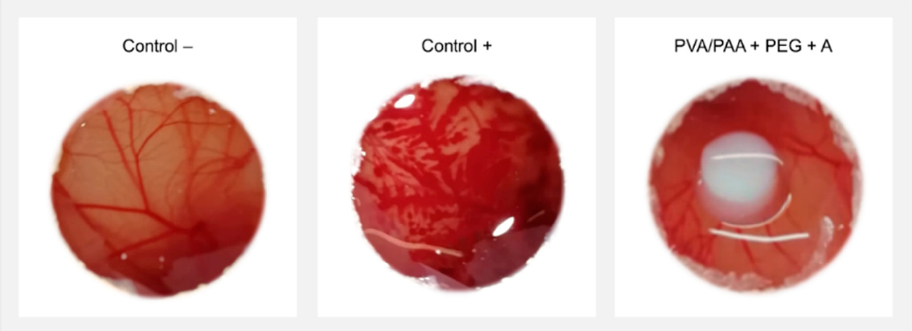
Figure 8. CAM images after incubating the annealed samples loaded with DFN for 5 min. Reaction with negative and positive controls are also shown.